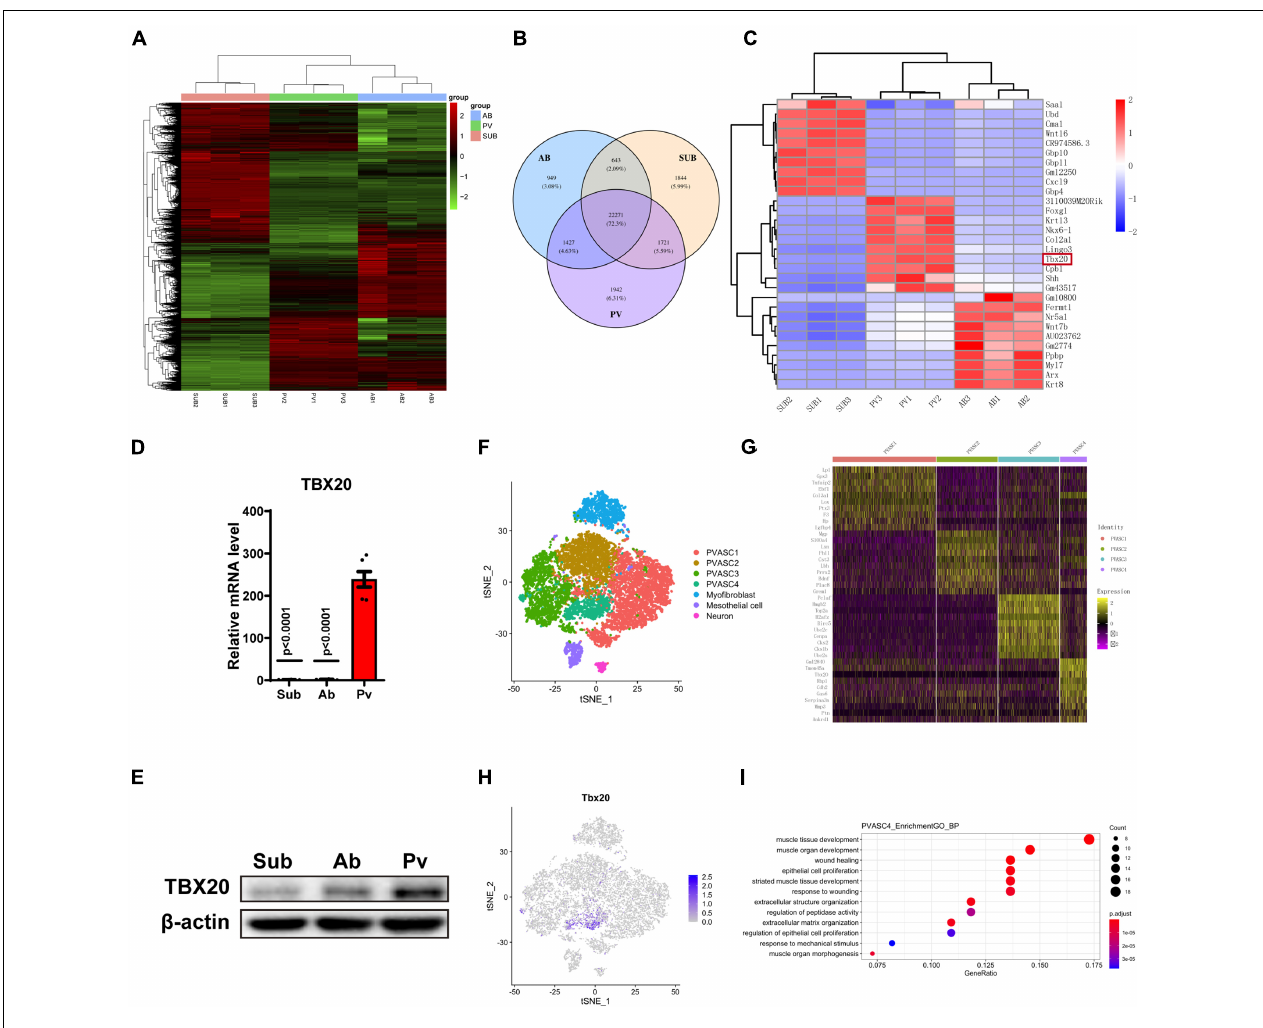
FIGURE 1 | TBX20 expressed highly in perivascular adipose-derived stem cells. (A,B) Bulk mRNA sequencing of subcutaneous (Sub), abdominal (Ab), and perivascular (Pv) ASCs. (C) Top 10 differentially expressed genes among subcutaneous, abdominal, and perivascular ASCs. (D) QPCR of TBX20 among subcutaneous, abdominal, and perivascular ASCs. (E) Western Blot of TBX20 among subcutaneous, abdominal, and perivascular ASCs. (F–I) Single-cell RNA-seq predicts the effect of TBX20 on capacities of PVASCs. (F) T-SNE map showing four subpopulations of PVASCs. (G) Heatmap displayed the expression of top 10 differential genes for four clusters. (H) Individual t-SNE visualization of TBX20 displayed the respective TBX20 + subpopulation. (I) Geno ontology analysis represented the biological process for